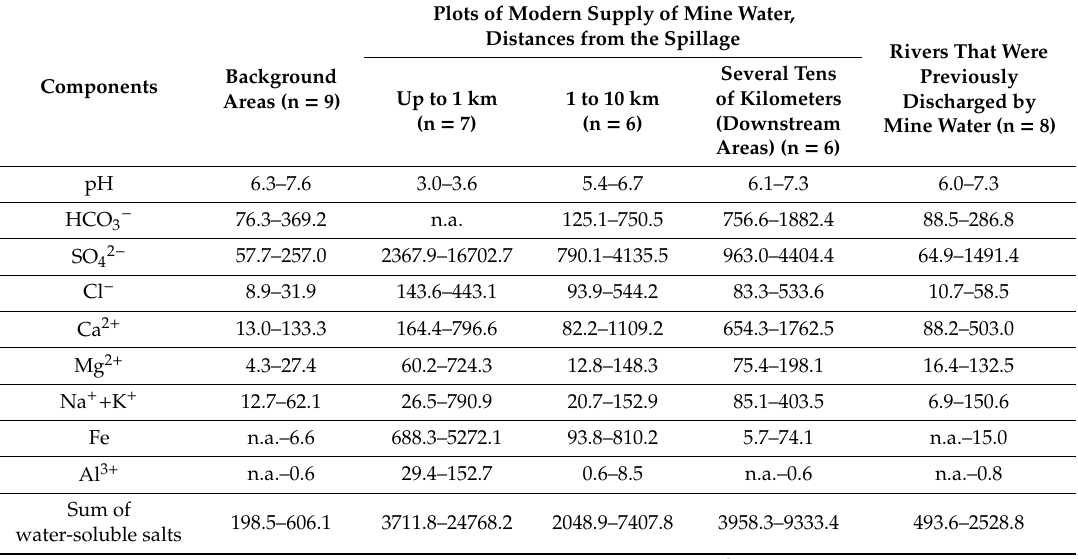
Table 3. Chemical composition of water extraction from bottom sediments in the Kizel coal basin rivers, mg / kg